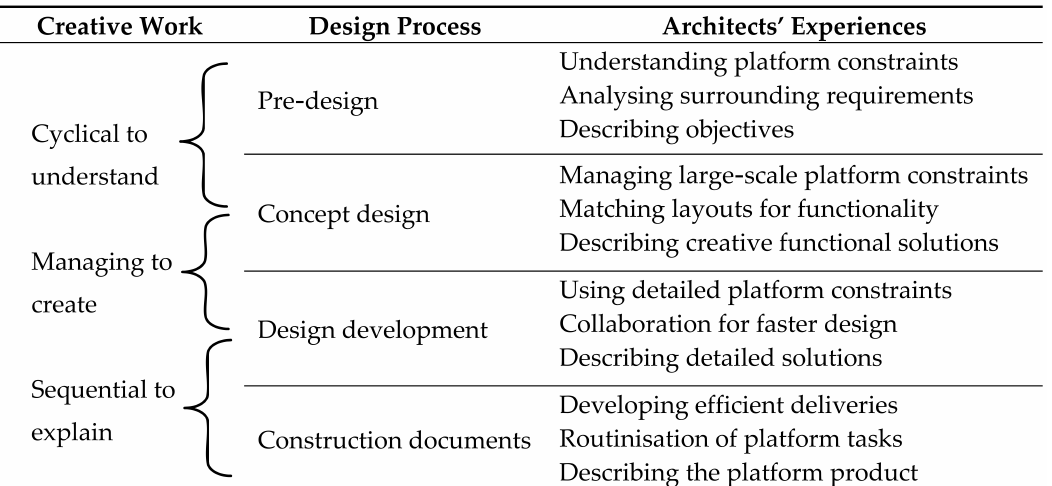
Table 1. Creative work from a process